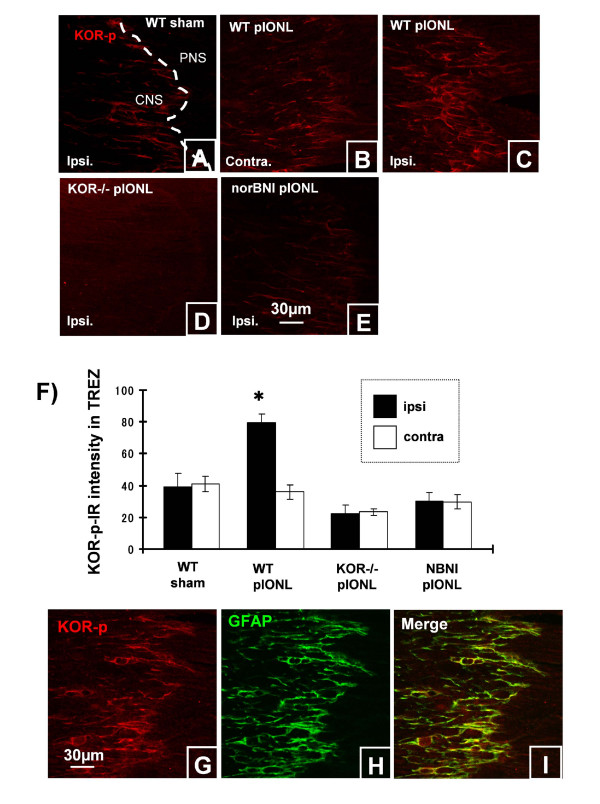
KOR activation in TREZ at day 8 after pIONL. (A), KOR-p-IR in sham operated WT mice. (B, C), increased KOR-p staining was seen within the root entry zone on the ipsilateral side compared to contralateral side following pIONL in WT mice. KOR activation was blocked by the deletion of kappa opioid receptor or norBNI treatment (D, E). (F), Mean ± SEM pixel intensity of KOR-p intensity in TREZ at day 8 after pIONL. (G-I), Double immunohistochemistry for KOR-p and GFAP in the TREZ at day 8 after pIONL. KOR-p staining is completely overlapped with GFAP staining. (*p < 0.001) Scale bars: A-E, 30 μm; G-I, 50 μm.